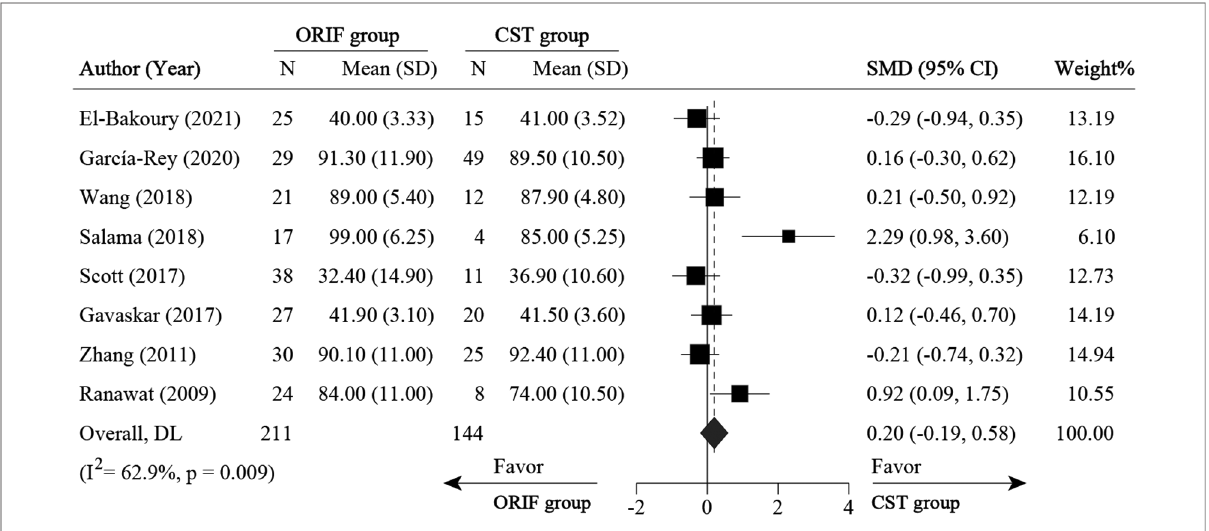
FIGURE 8 Meta-analysis for HHS and OHS comparison between ORIF and conservative treatment. CST, conservative treatment or non-surgical treatment; HHS, Harris Hip Score; OHS, oxford hip score; ORIF, open reduction and internal fi xation; SD, standard deviation; SMD, standard mean difference.